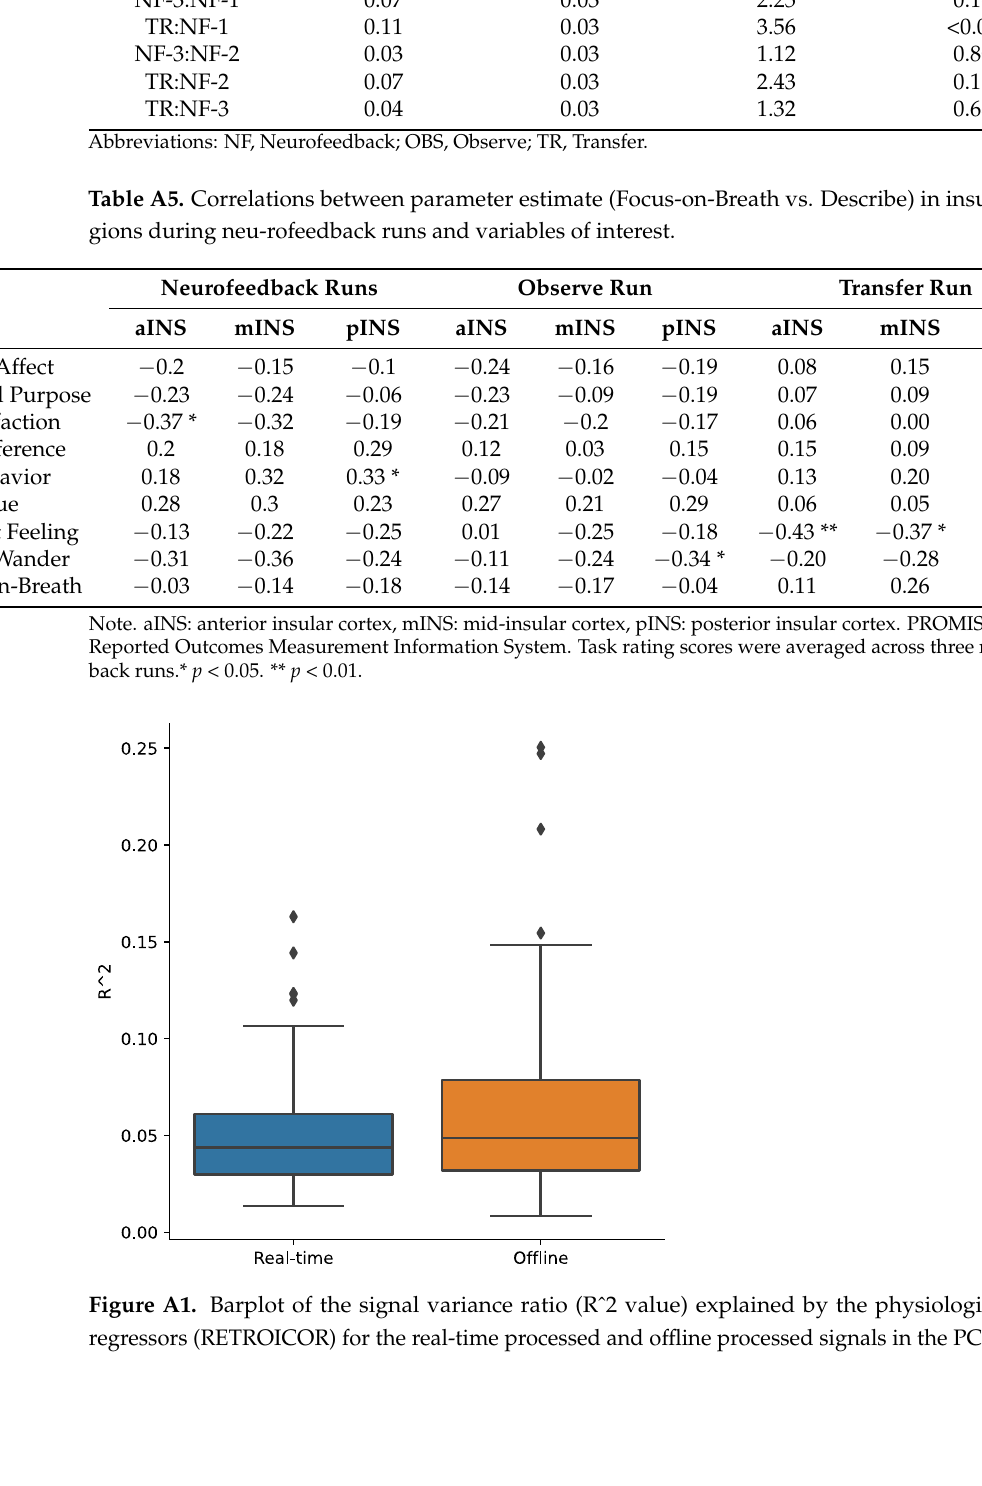
Figure A2. ( a – c ), parameter estimate (Focus-on-Breath vs. Rest) across runs for insula subregions. Abbreviations: OBS, Observe; NF, neurofeedback run; TRS, Transfer * p < 0.05. ** p < 0.01. *** p < 0.001. Figure A3. Scatterplot of significant correlations between parameter estimate (Focus-on-Breath vs. Describe) in insula subregions during neurofeedback runs and PROMIS measures. References 1.